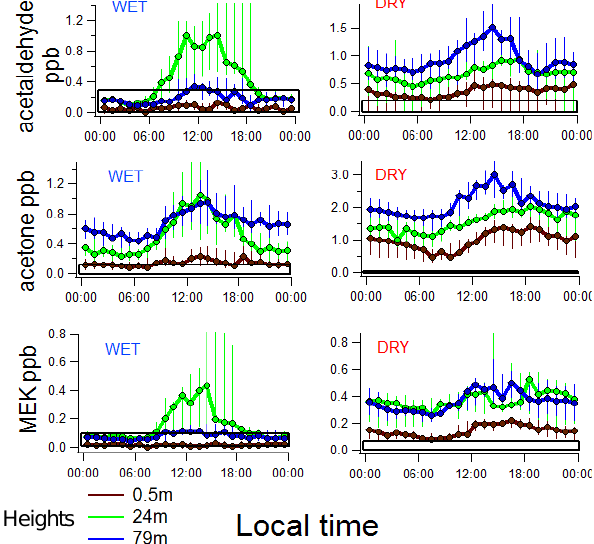
Figure 8. Diurnal medians for the wet season (left) and dry season (right), for acetaldehyde (top), acetone (middle) and methyl ethyl ketone (bottom) at different heights. Range bars are expressed as the 25 and 75%